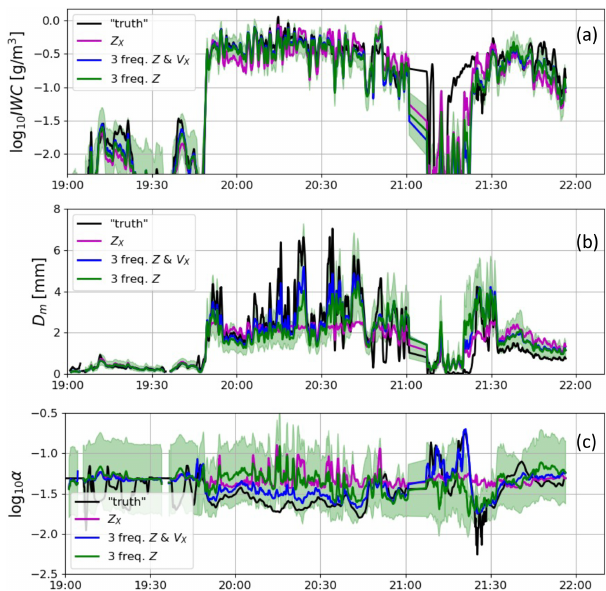
Figure 4. The results of different microphysical retrieval along the validation flight. The black line, denoted as truth, shows the micro- physical properties of snow derived in Sect. 3.2 using the optimal estimation framework that combines information provided by the PSD measurements, Nevzorov probe and radar data together. The green, blue and magenta lines correspond to the retrievals based on the triple-frequency reflectivity, triple-frequency reflectivity with the mean Doppler velocity at the X-band and the algorithm based on the X-band reflectivity only, respectively. The green shading shows the uncertainty in the triple-frequency